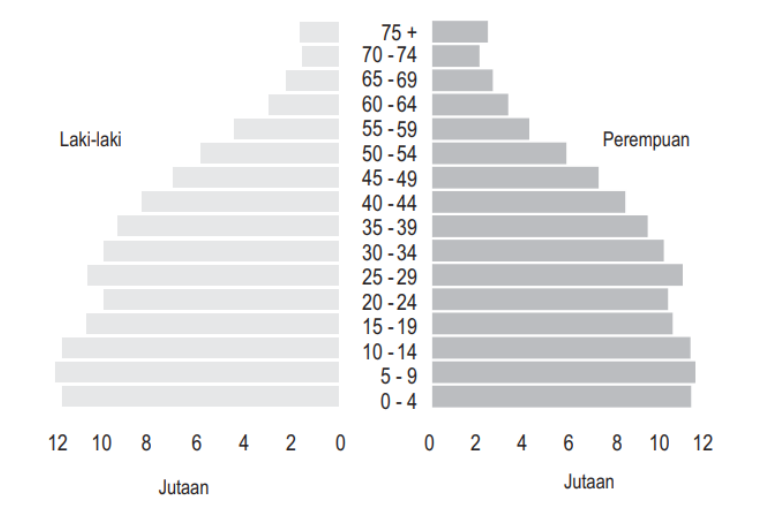
Figure 1: Pyramid of Population Results of the 2010 Census; Source: Badan Pusat Statistik,